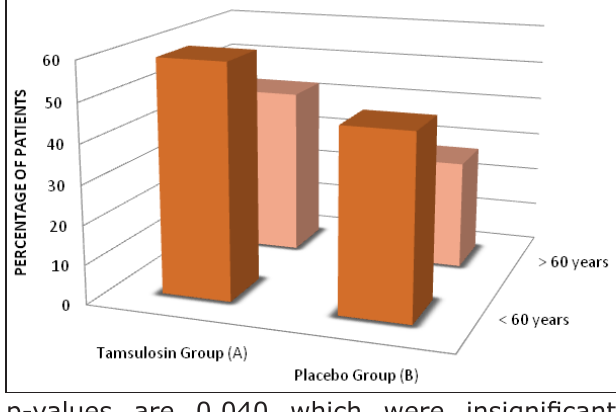
Figure-I: Stratification of patients according to